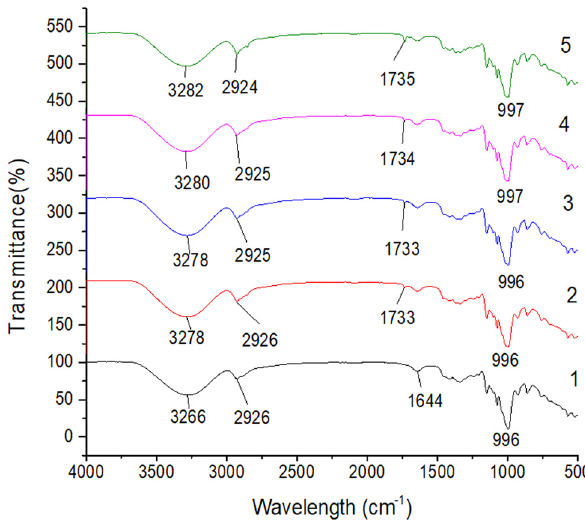
Figure 3: FTIR spectra of cinnamon EO - incorporated SPS/SPNCC nanocomposite fi